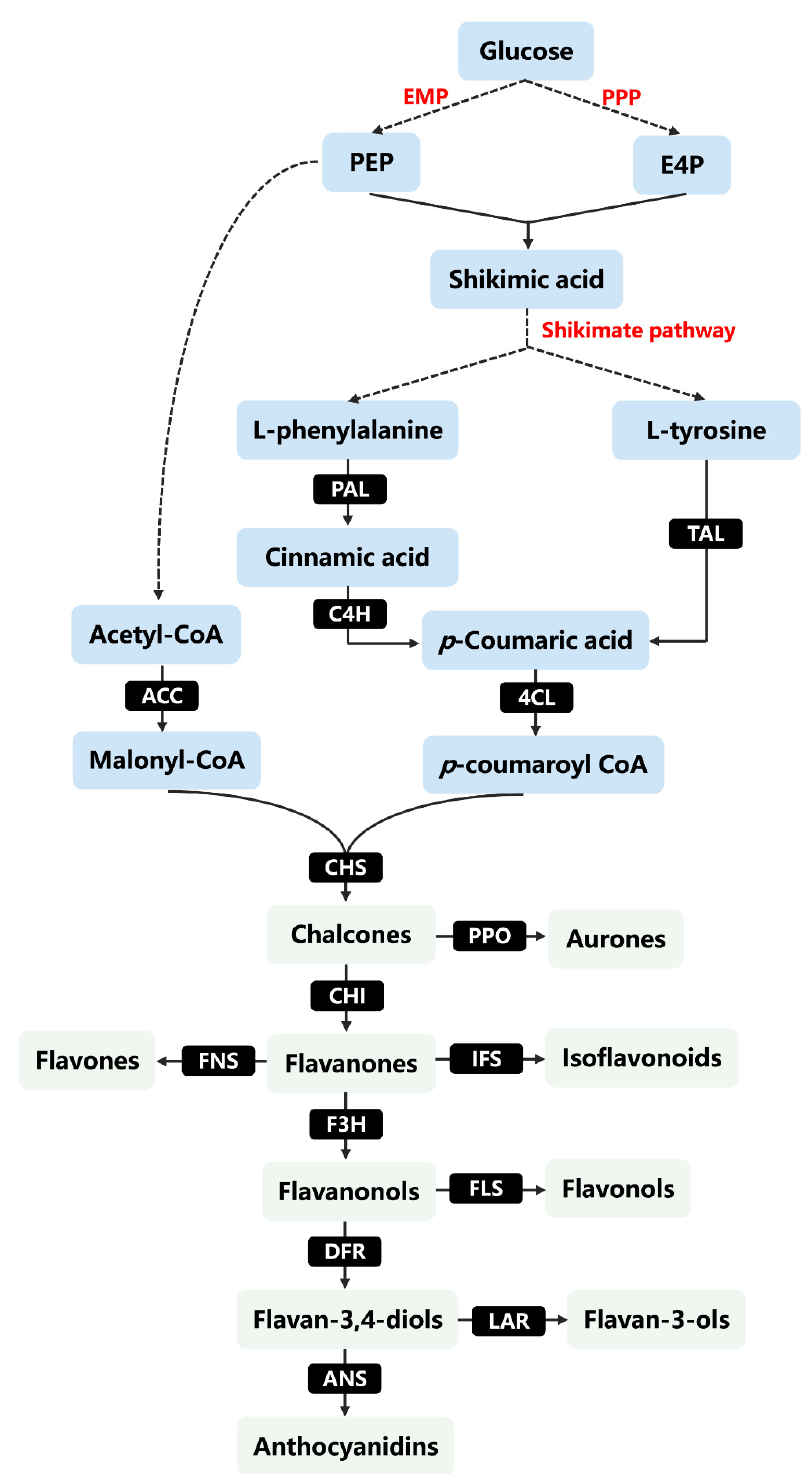
Figure 2. Biosynthesis pathway network of flavonoids in plants. EPM: glycolytic pathway; PPP: pentose phosphate pathway; PEP: phosphoenolpyruvate; E4P: erythrose 4-phosphate; PAL: phenylalanine ammonia lyase; C4H: cinnamate 4-hydroxylase; TAL: tyrosine ammonia-lyase; 4CL: 4-coumarin-CoA ligase; ACC: acetyl-CoA carboxylase; CHS: chalcone synthase; CHI: chalcone isomerase; PPO: polyphenol oxidase; F3H: flavanone 3-hydroxylase; IFS: isoflavone synthase; FNS: flavone synthase; DFR: dihydroflavonol 4-reductase; FLS: flavonol synthase; LAR: leucoanthocyanidin reductase; ANS: anthocyanidin